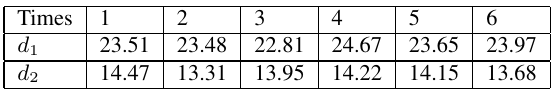
Table 1: The comparison of average position bias d in the